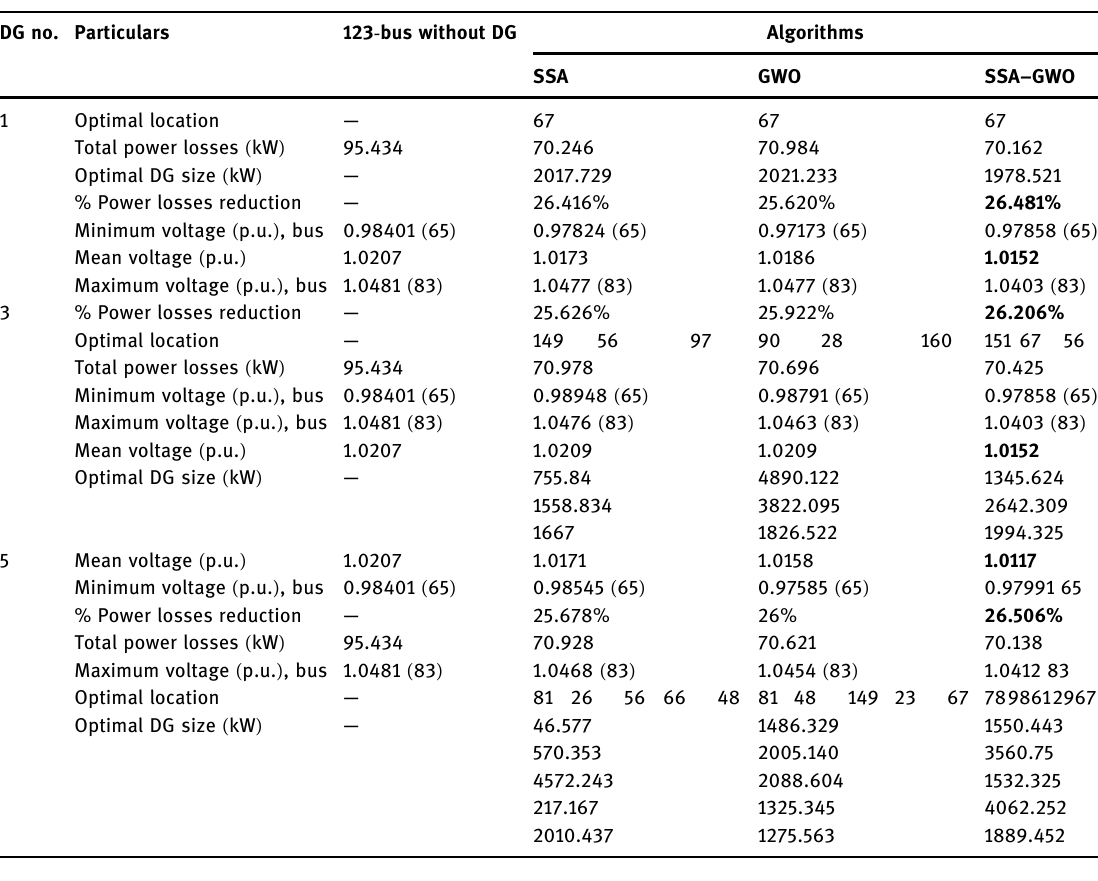
Table 2: Performance of SSA – GWO compared with IEEE standard case, SSA, and GWO algorithms on IEEE 123 - node with DGs